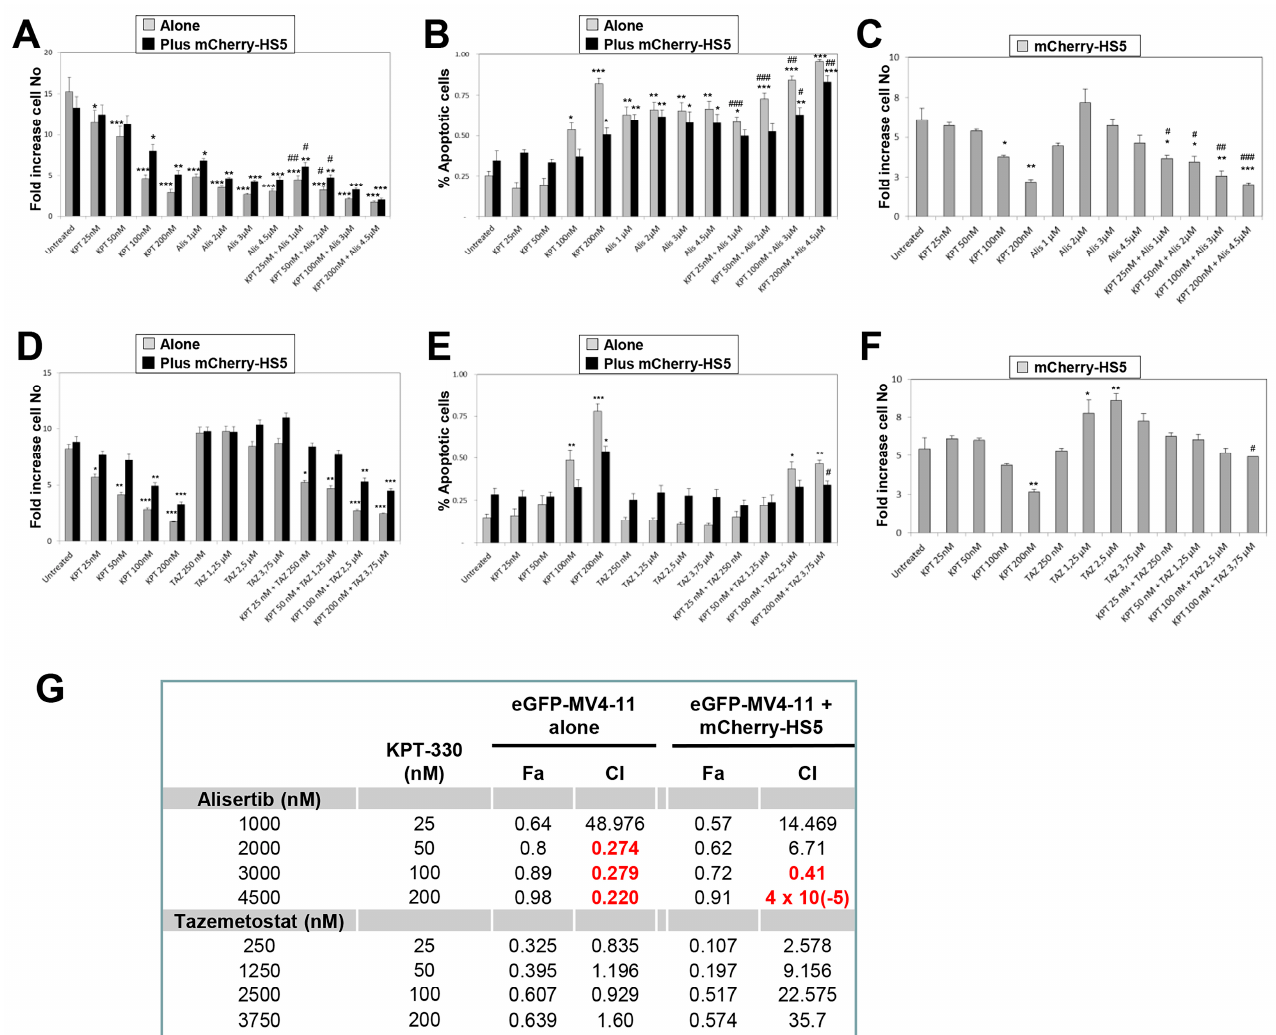
Figure 8. Analysis of the anti-proliferative and pro-apoptotic effect of the combination of KPT-330 with alisertib or tazemetostat. eGFP – MV4-11 cells cultured alone or in the presence of mCherry – HS5 cells were left untreated or were treated with KPT-330 alone or in combination with alisertib ( A – C ) or tazemetostat ( D – F ). Graphs show the impact of the treatments on the proliferation of eGFP – MV4-11 cells ( A , D ), the levels of apoptosis in eGFP – MV4-11 cell cultures ( B , E ), and on the proliferation of mCherry – HS5 cells ( C , F ). * p < 0.05, ** p < 0.01, *** p < 0.005 ANOVA versus control untreated in the same culture condition. # p < 0.05, ## p < 0.01, ### p < 0.005 post-hoc Student T-test comparing the efficacy of a drug combination with the treatment at the same concentration with KPT-330 as a single agent. ( G ) Table showing the fraction affected (Fa) and combination index (CI) of alisertib or tazemetostat at the specified concentration in combination with 25, 50, 100, and 200 nM of KPT-330. CI values labelled in red indicate synergism or very strong synergism, according to the Chou–Talalay